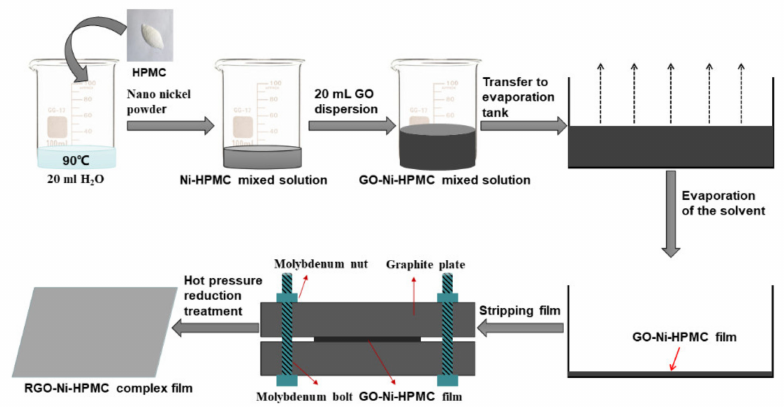
Figure 1. Flowchart of preparation of RGO-Ni-HPMC composite